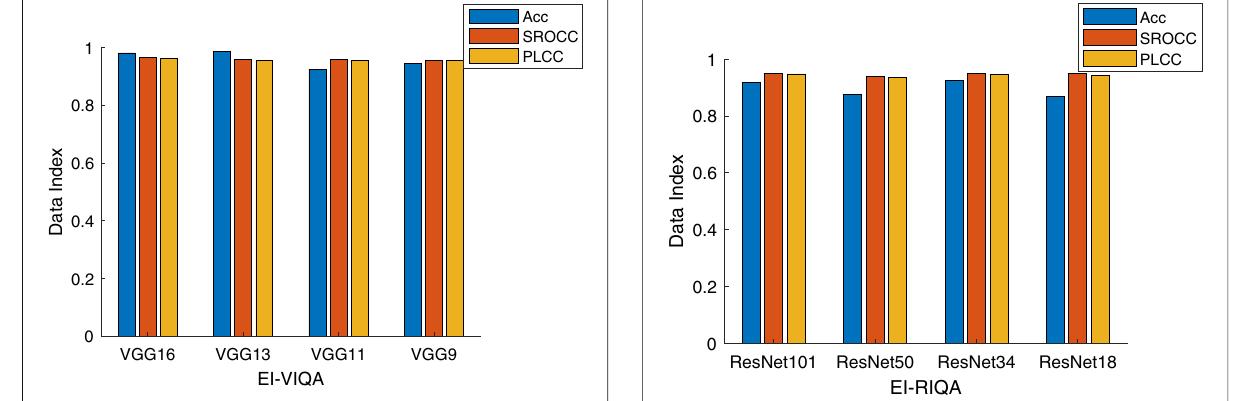
In Table 12, the depth of the ResNet network is reduced, and then different levels of explicit features are combined.